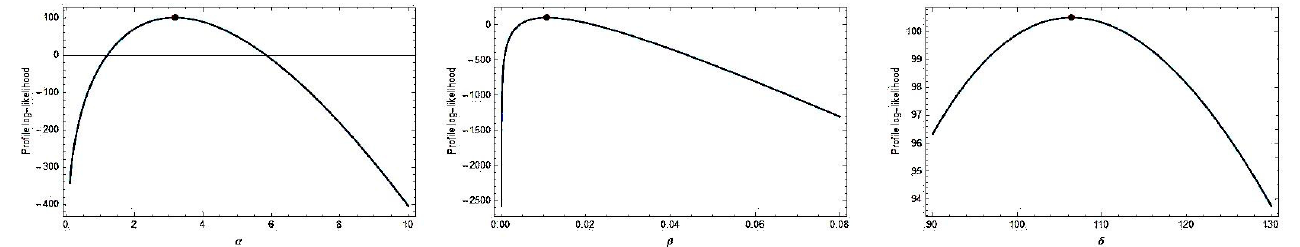
Figure 10. Behavior of log-likelihood function with 3PB model parameters for burr data set.